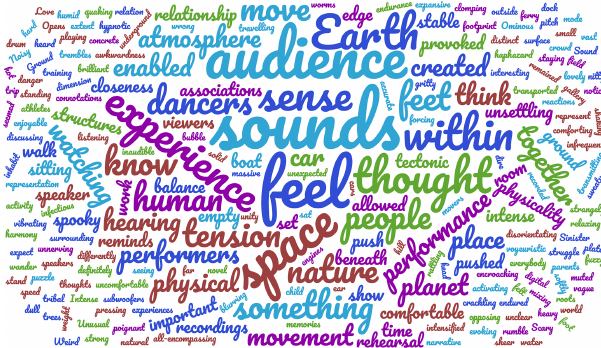
Figure 14. A word cloud formed by counting the occurrence of words in comments from participants, the audience, and performers in art performances and installations developed by Shirley Pegna, as part of the Unsettled Planet project. Performances include the All Terrain Training and the Earth Din projects. The installations are Ground Sound and You Are Here (see